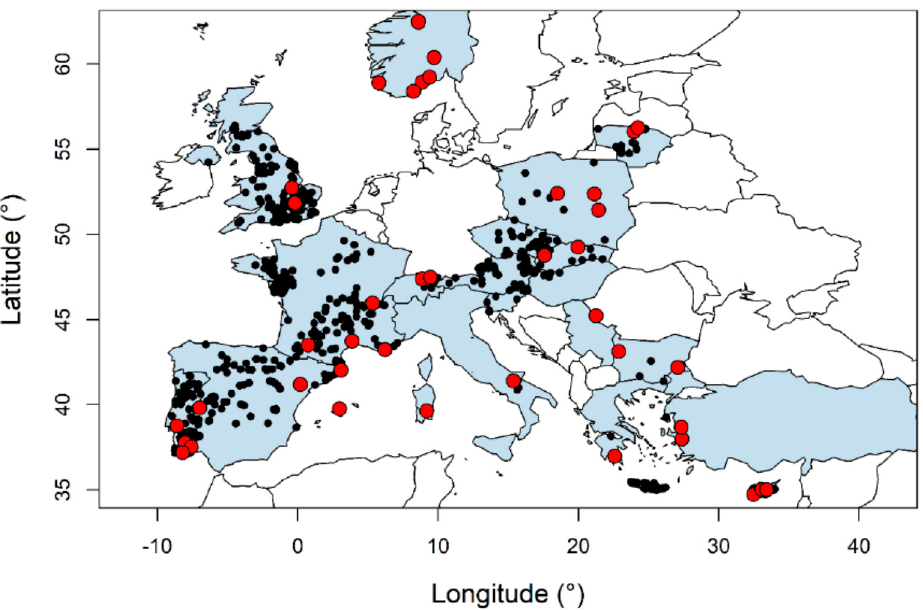
Figure 7. Location of intermittent rivers and ephemeral streams (IRES) catchments presented in the SMIRES catalogue. Red dots indicate examples of gauging stations included in the catalogue; black dots represent gauging stations that met the intermittence criteria, but were not included in the catalogue. Blue shading indicates countries of members involved in project data sharing. Reproduced